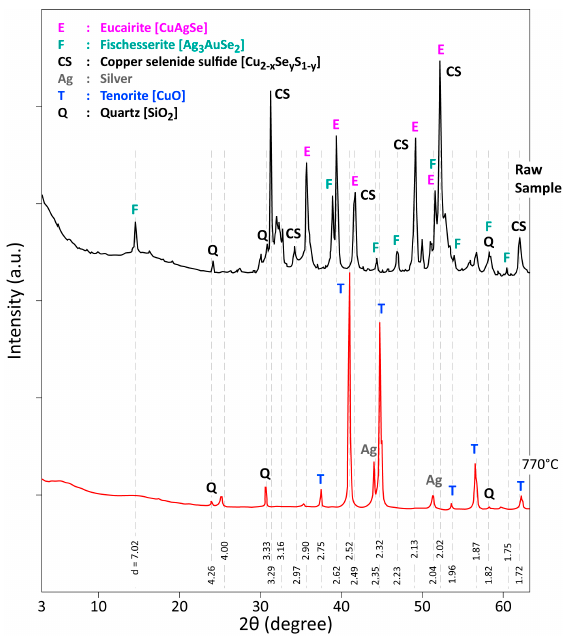
Figure 7. XRD patterns of a CAS raw sample and its treatment product in air at 770 °C.